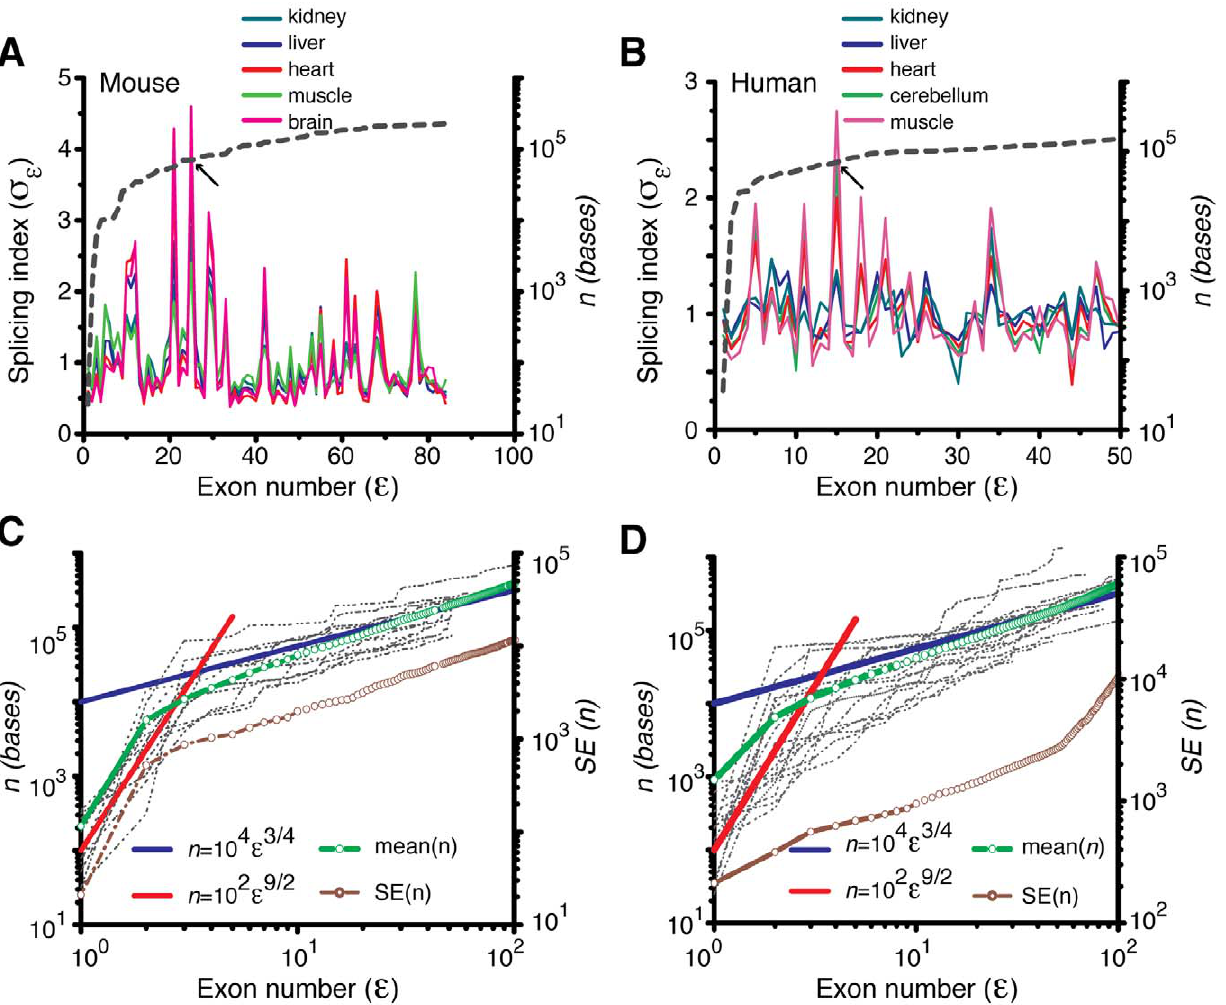
Figure 3. A. Example showing the splicing index ( s e ) as a function of the annotated exon number e in mouse gene Dtnb (dystrobrevin beta, NM_007886, Affymetrix Transcript ID: 6792942). The example illustrates a constitutive splicing pattern across different tissues. The dashed line (right-axis) shows the exon position (bases) based on the annotations. The plot suggests that there is a coarse optimum exon position (arrow) associated with a maximum splicing index; across different genes this maximum is coarsely around the predicted value of n , 7 6 10 4 bases in the original pre-mRNA. More examples are shown in Figure S1 . B. Example showing the splicing index of the human vitrin gene (VIT, Affymetrix Transcript ID: 2477203, NM_053276). The format is the same as in part A . More examples are shown in Figure S2 . C–D. Scaling relationship between exon number ( e ) and exon position ( n ) on the pre-mRNA transcript for mouse ( C ) and human ( D ). Here positions versus exon numbers for 18 human genes (Transcript id (number of exons), 2598971 (93), 2975385(79), 3123036(30), 2688813(40), 2753440(153), 2975385(79), 2477073 (87), 2477203 (50), 2480700 (114), 2481308 (49), 2481379 (48), 2481929 (54), 2482505 (80), 2552368 (56), 2638509 (69), 2639734 (68), 2828564 (79), 2639552 (134) and 14 mouse genes (6991267 (39), 6946339 (86), 6770718 (40), 6839871 (51), 6946339 (86), 6998972 (64), 6990167 (147), 6805180 (61), 6805180 (61), 6747313 (25), 6747308 (23), 6747314 (38), 6751304 (96), 6771558 (18)) with different number of exons were obtained from the transcript and probe level Affymetrix annotations. In line with Eq. 17 , when e w 3 we approximate n ~ h e ð Þ * 10 4 e 3 = 4 . Green line-dots are the mean positions of exons. Brown line-dots are the standard error (SE) associated with the positions of exons. The scaling transformation n ~ h e ð Þ shows an error of ,